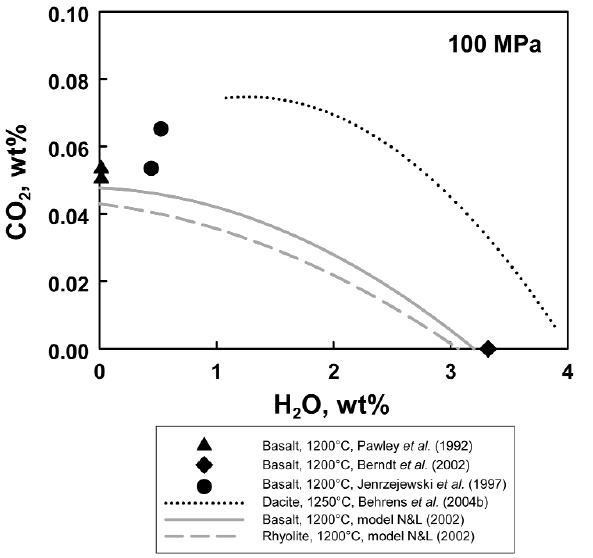
Fig. 3. Solubilities of H 2 O and CO 2 in basaltic (dots) and dacitic (dotted line) melts at 100 MPa. The dataset for dacitic melt and the experimental procedure is described in detail by Behrens et al . (2004b). Gray lines show modeled solubilities of volatiles in rhyolitic (dashed line) and basaltic (solid line) melt